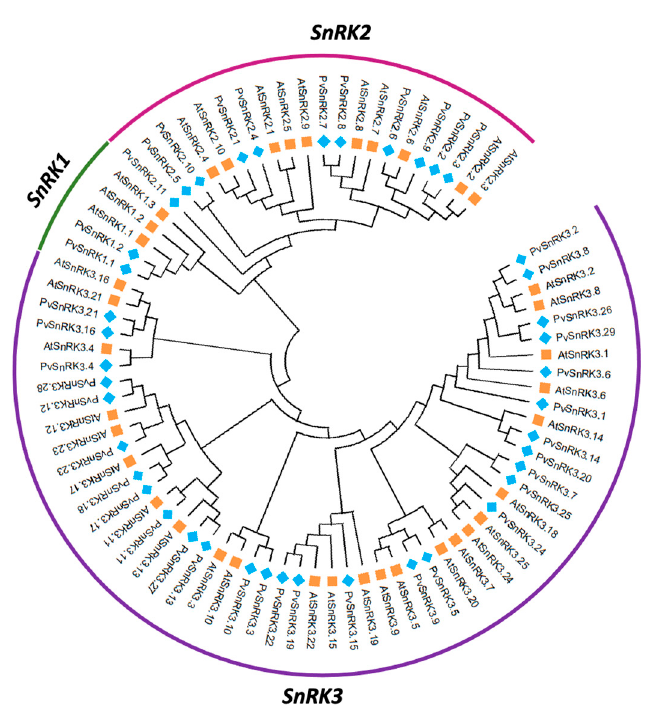
Figure 1. Phylogeny of the SnRK gene family in Arabidopsis thaliana and Phaseolus vulgaris . Phyloge- netic tree constructed with distance and neighbour-joining method using deduced full-length protein sequences of SnRK family genes of two species. The phylogenetic tree was constructed using MEGA XI software with the neighbour-joining tree method with 1000 bootstrap